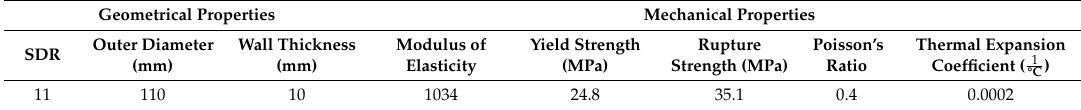
Table 1. Geometrical and mechanical properties of PE100 socket.